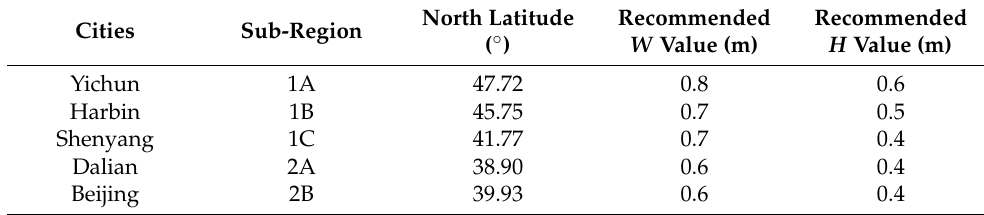
Table 17. Recommended horizontal sunshade dimensions.